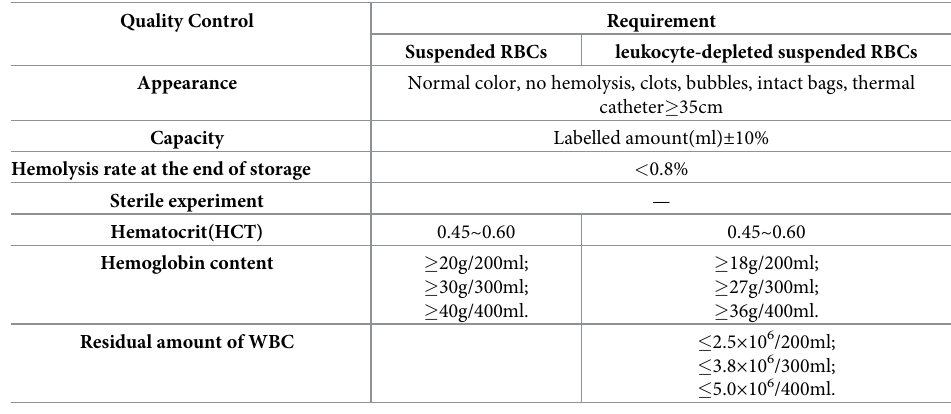
Table 3. Quality control and requirement of suspended RBCs and leukocyte-depleted suspended RBCs